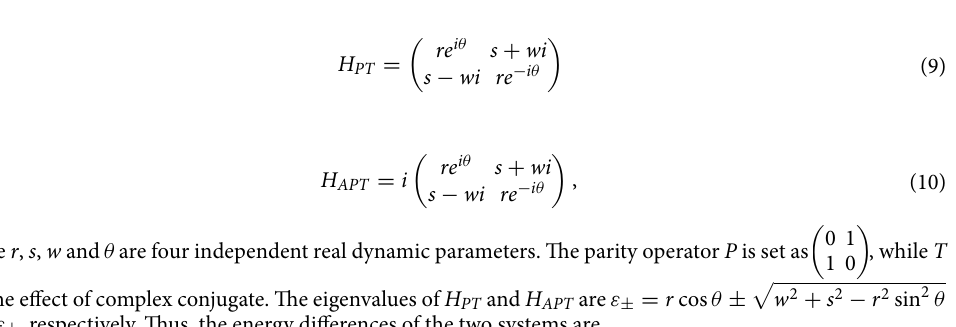
where r , s , w and θ are four independent real dynamic parameters. The parity operator P is set as has the effect of complex conjugate. The eigenvalues of H PT and H APT are ε ± = r cos θ ± and i ε ± , respectively. Thus, the energy differences of the two systems are